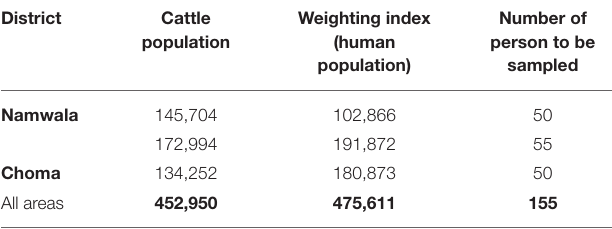
TABLE 1 | Sample size of humans weighted against cattle population per district. Number of District Cattle Weighting index person to be population (human sampled population) Namwala 145,704 102,866 50 172,994 191,872